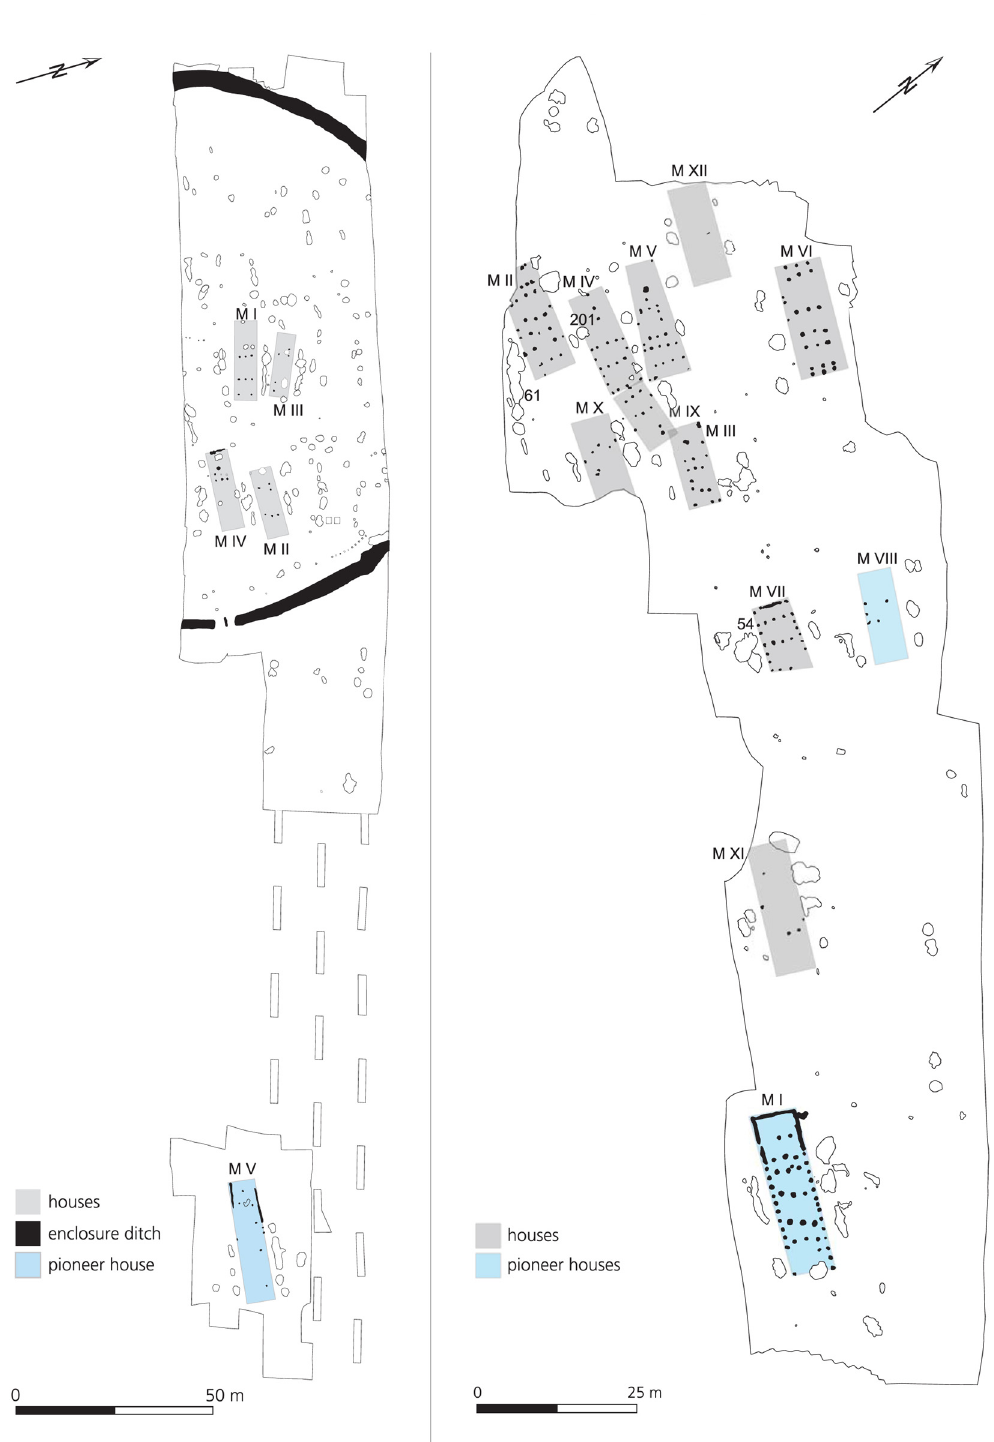
Figure 7: Pioneer houses and enclosed LBK village of Fexhe le - Haut - Clocher and Remicourt En Bia Flo II ( Hesbaye ) ( after Bosquet & Golitko, 2012, Figures 4 and 5 )